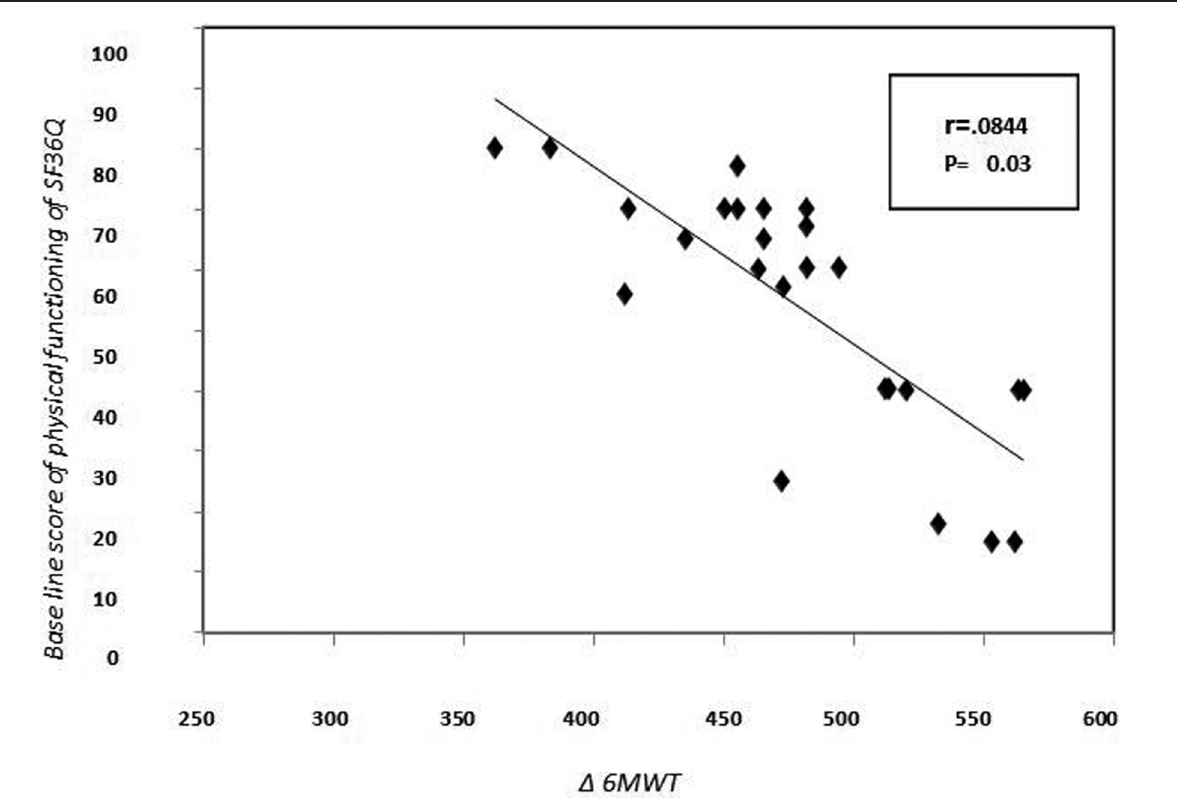
Scattered plot with regression line shows negative correlation between baseline physical functioning item of SF36Q and Δ 6MWDT. 6MWDT, 6 min walk distance test; SF36Q, short-form health survey